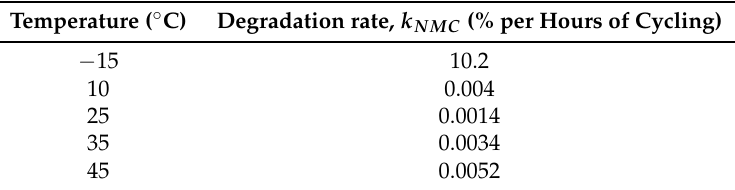
Table 3. Degradation rate of NMC/G pouch